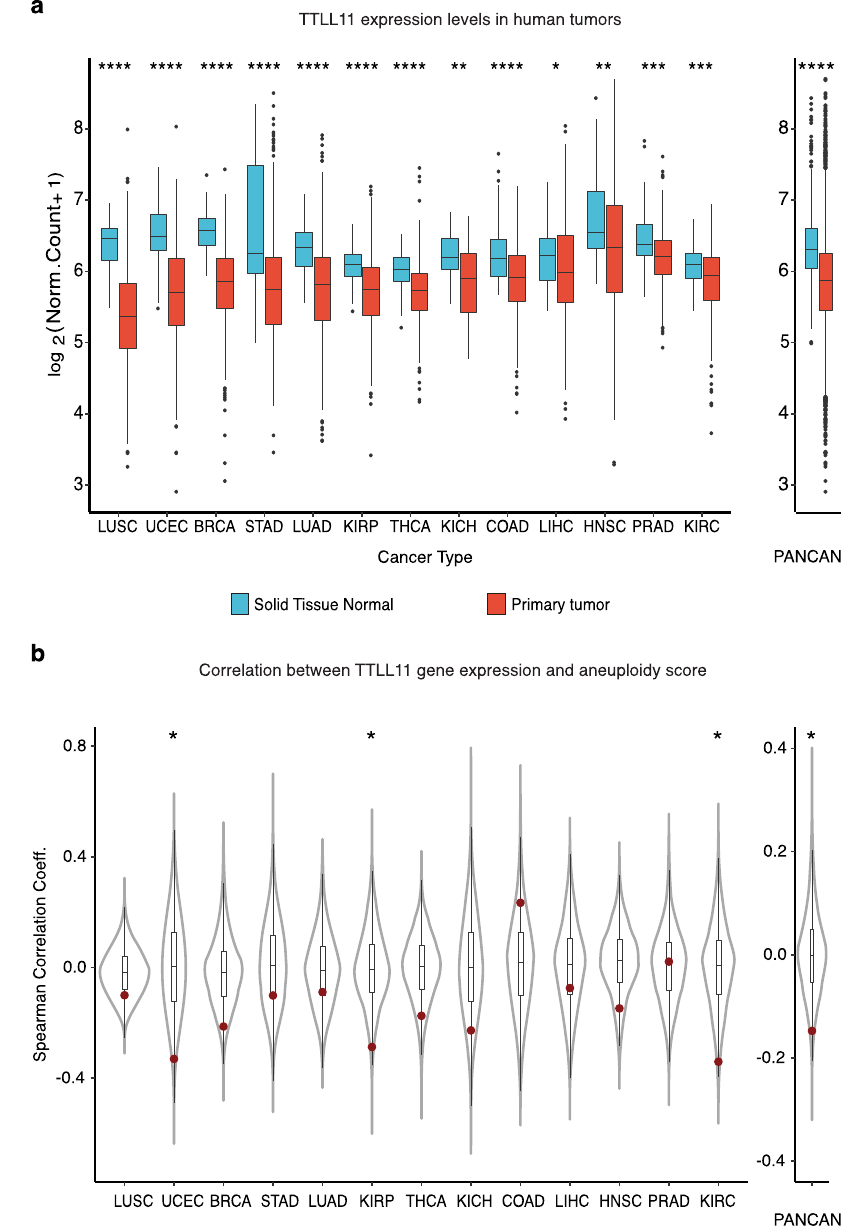
Fig. 4 | TTLL11 expression is downregulated in tumors and correlates nega- tively with aneuploidy scores. a Normalized expression of TTLL11 in healthy tis- sues and the corresponding primary tumor samples across 13 different cancer types, separately and combined (PANCAN). Nominal P values: **** P ≤ 0.0001; *** P ≤ 0.001; ** P ≤ 0.01; * P ≤ 0.05; based on unmatched two-sided Wilcoxon rank- sum tests. The number of samples per cancer type and sample type (see Supple- mentaryTable3).Ineachboxplot,themedianvalueisindicatedasahorizontalline and the lower and upper bounds of the box correspond to the fi rst- and third quartiles, respectively. The upper- and lower whiskers range from the corre- sponding box hingesto the largest value no further than1.5 timesthe interquartile range from the hinge. All outlying data points beyond the whiskers are plotted